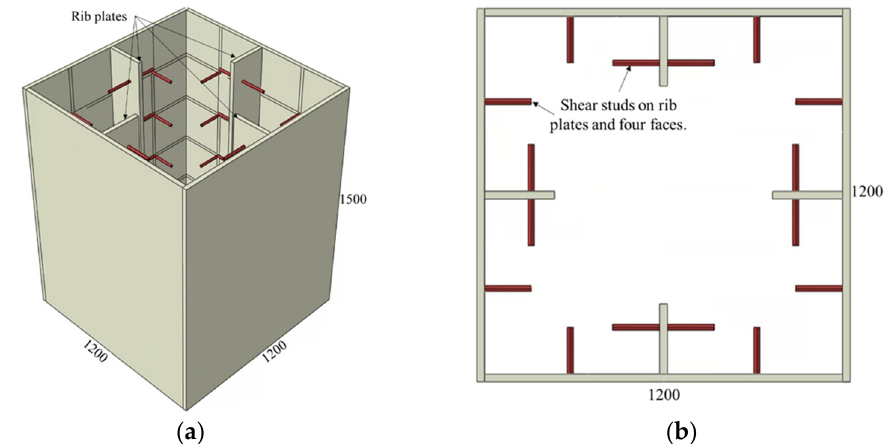
Figure 5. CFST column with rib plate and shear stud connectors: ( a ) 3D view and ( b ) top view.